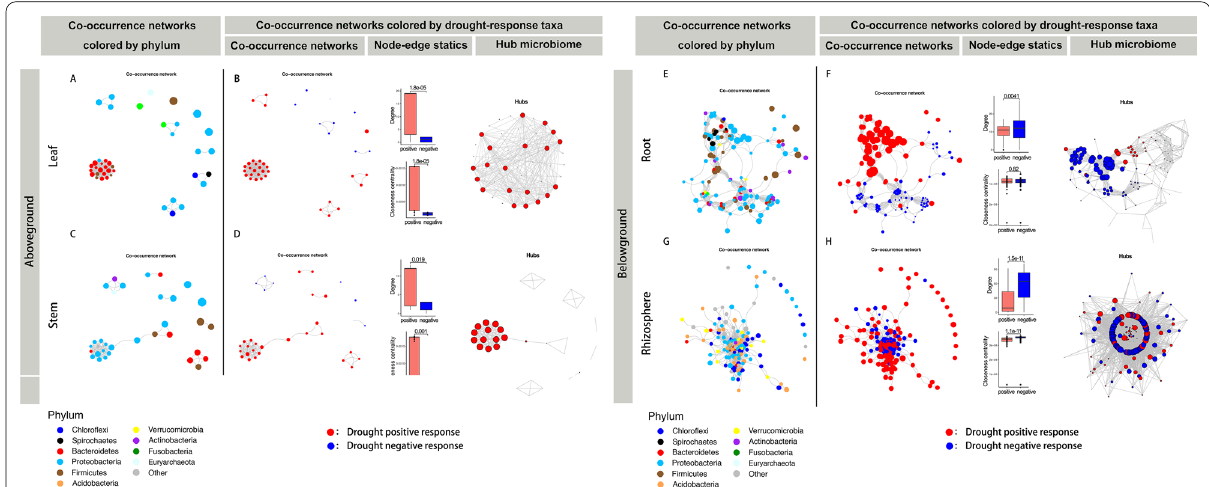
Fig. 5 Metacommunity co-occurrence patterns of drought-negative and drought-positive response microbiomes of O. longistaminata . Co-occurrence relationships with strong Spearman’s correlation values ( p value < 0.5 and abs(r) > 0.6) are depicted for each compartment. A , C , E , G Community co-occurrence networks. Networks are colored by phylum and sized based on the relative abundance of the ASV (log10-fold change in relative abundance). B , D , F , H Metacommunity co-occurrence networks of drought-negative and drought-positive response microbiomes (left panels). The networks are colored and sized based on drought-negative and drought-positive response ASVs. The figures are a summary of node-edge statics (middle panels). The network figure on the right is hub (keystone) microbiome species within the co-occurrence network. Networks are colored based on drought-negative and drought-positive response ASVs and sized based on the hub score of the